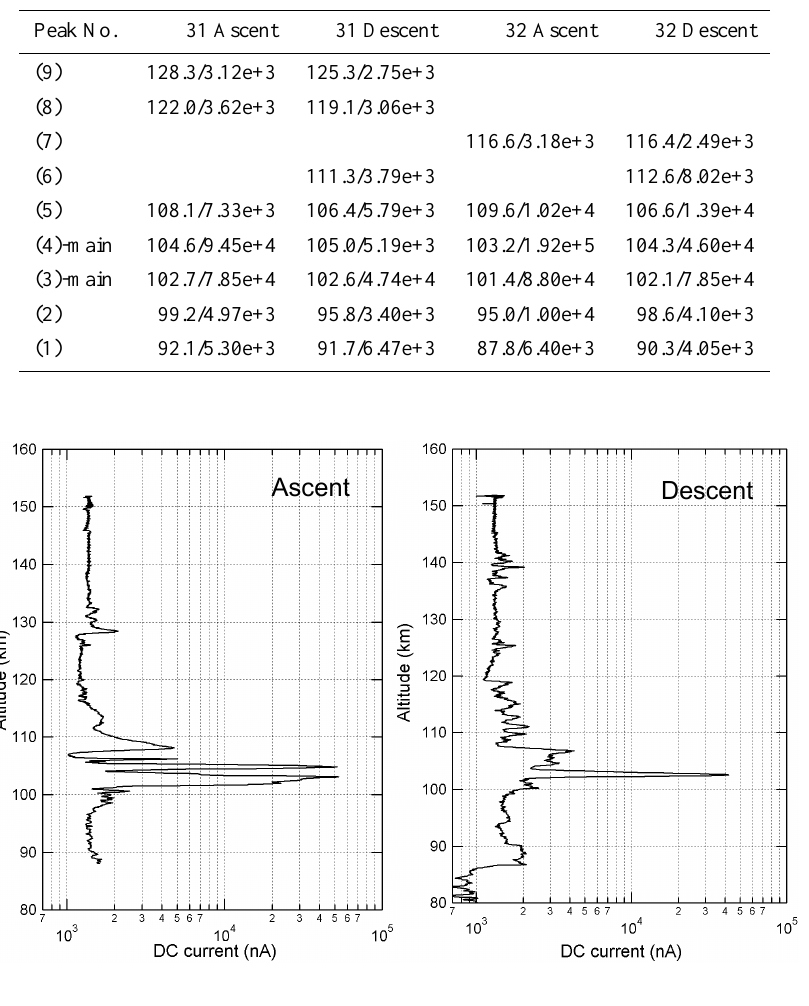
Figure 5. The FBP observation results obtained by S310-31 rocket. These panels represents DC current components.